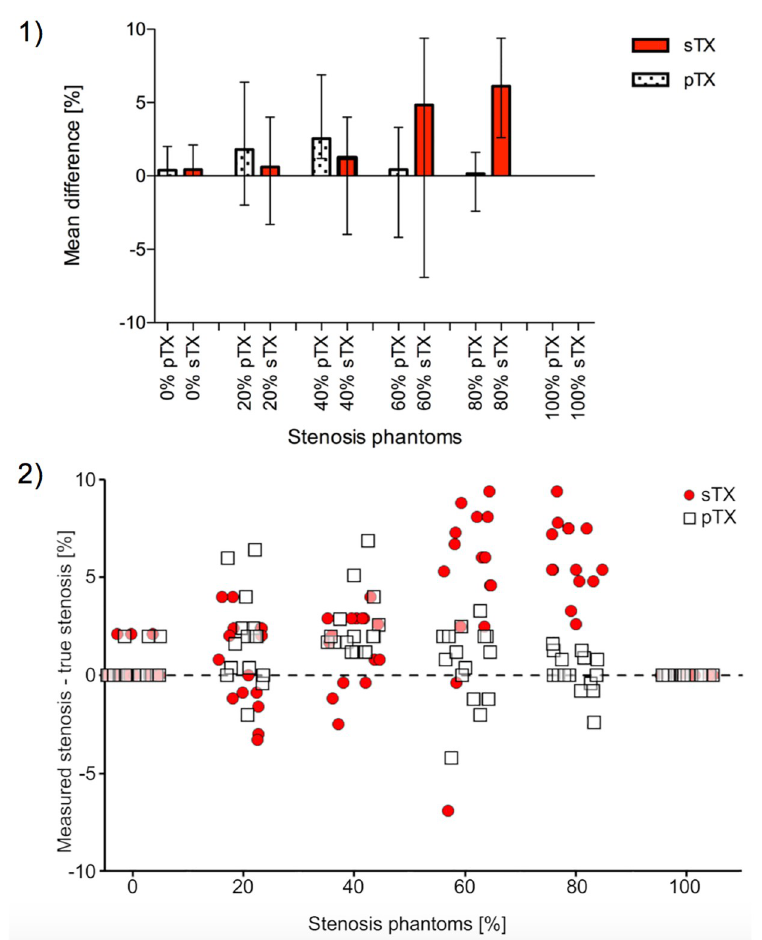
Fig 6. Measurement accuracy in stenosis quantification using a conventional single transmit coil (sTX) and a parallel transmission (pTX) coil with B 1 -shimming. (1) For higher-grade stenoses, the mean differences obtained by subtracting real measures of the 3D-printed phantoms from MRI measurements were significantly lower (60% and 80%: p < 0.01) using pTX with B 1 -shimming. Error bars indicate the range of the differences across the phantoms. (2) Deviation from actual stenosis determined with pTX (white squares) and sTX (red circles). To visualize the individual data points, the values on the x-axis (true degree of stenosis) are not fixed to a single value (e.g. 20%), but have a range of +/-5% (e.g. 15% to 25%). The y-axis indicates the difference between the stenosis measured with the respective technique and the true degree of stenosis.